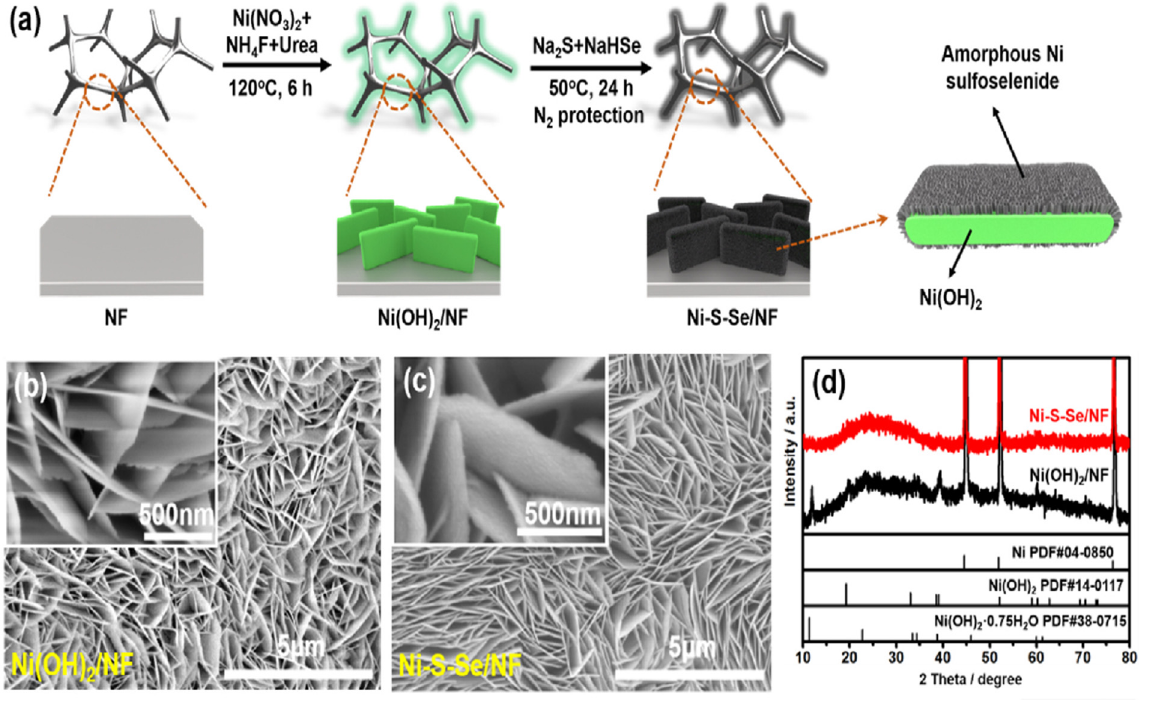
Figure 22. ( a ) Schematic illustration of the preparation of Ni-S-Se/NF, ( b , c ) SEM images and ( d ) XRD patterns of Ni(OH) 2 /NF and Ni-S-Se/NF, respectively. Reprinted with permission from Ref. [101].